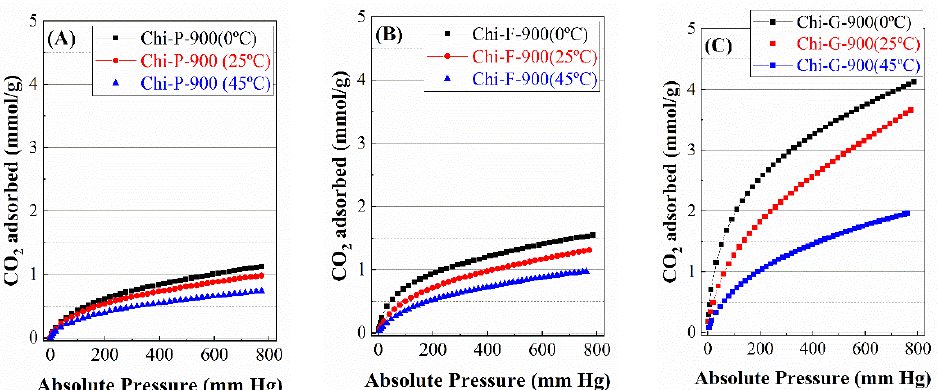
Figure 11. CO 2 adsorption isotherms at 0–45 ◦ C and 1 bar of the biochars obtained after the pyrolytic treatment of chitosans with different textural properties at 900 ◦ C. ( A ) biochars obtained form chitosan directly, ( B ) biochars obtained from chitosan in the form of film and ( C ) biochars obtained from chitosan in globular form.